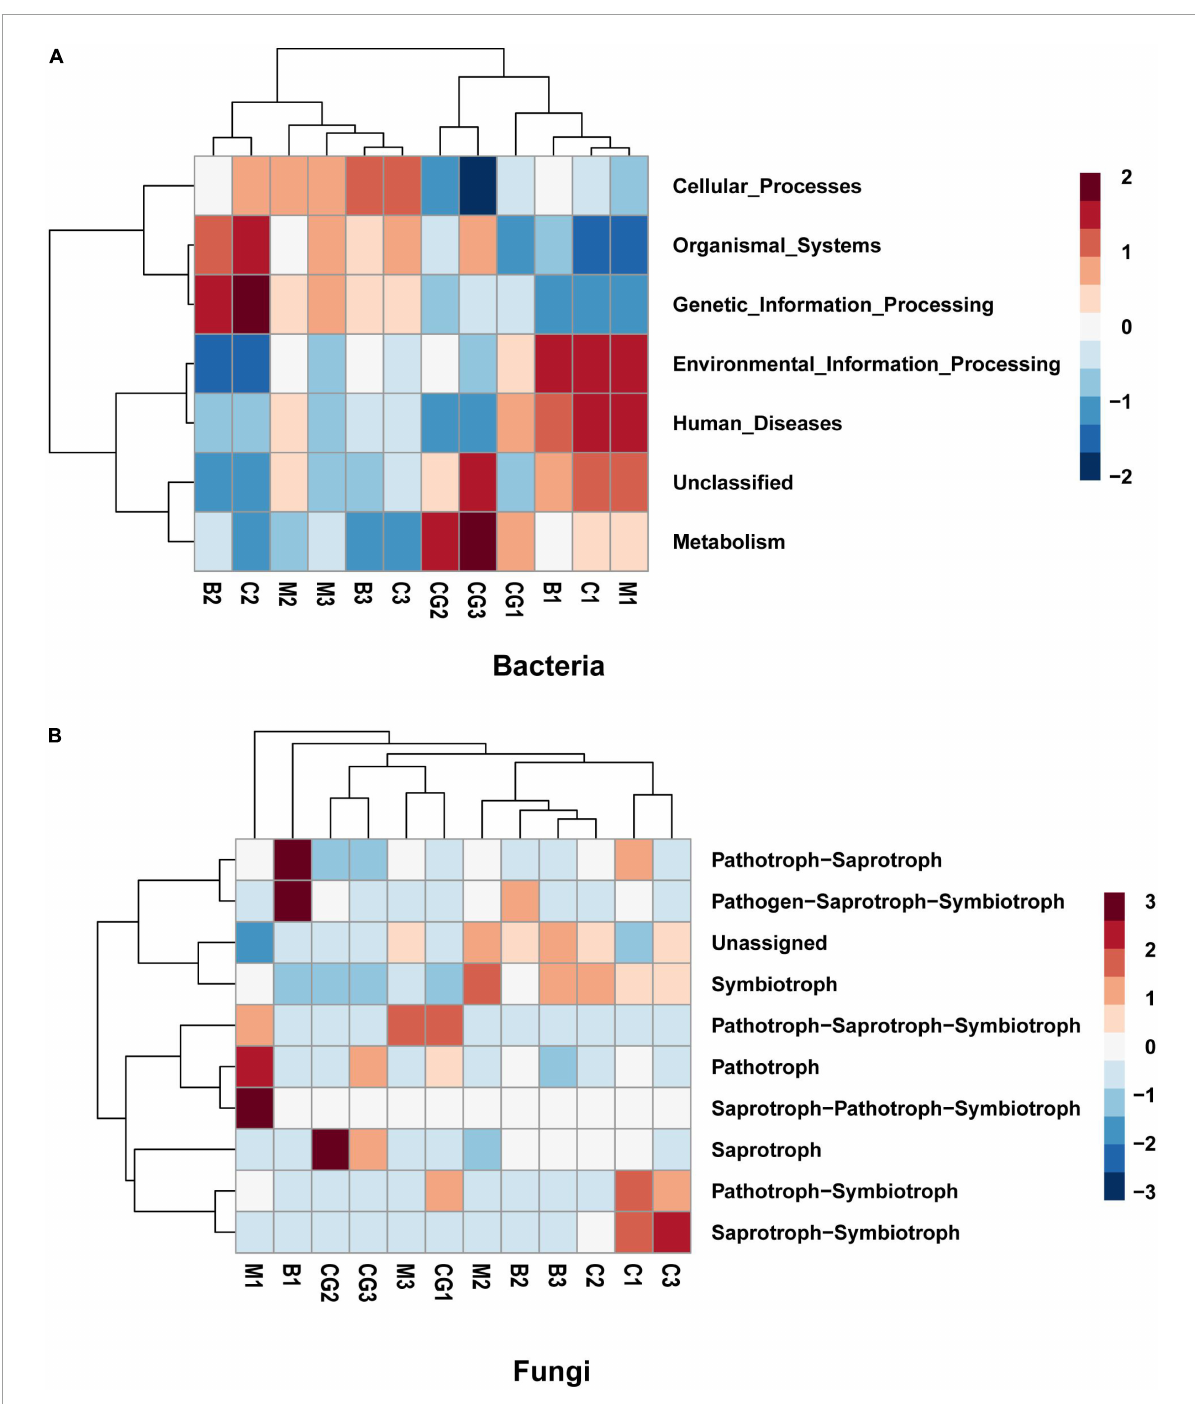
FIGURE7 Predicted function of the bacterial and fungal communities. (A) Bacterial community, (B) fungal community. The letters in group ID represents nest material type (B, bamboo leaf; C, couch grass; M, mixed litters; CG, control group); Arabic numerals represent different incubation periods (1, pre-incubation; 2, mid-incubation; 3,